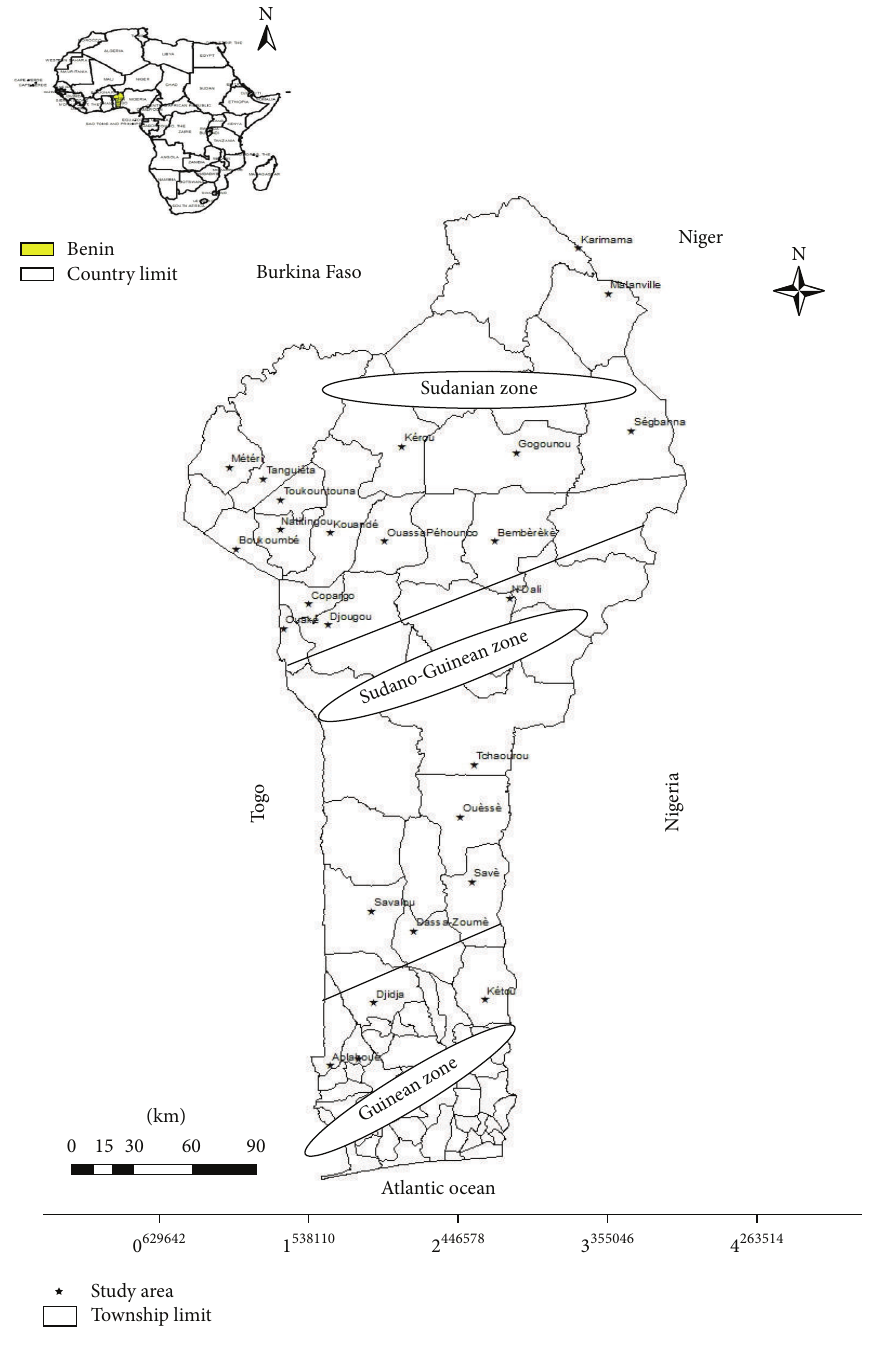
Figure 1: Map showing zones of